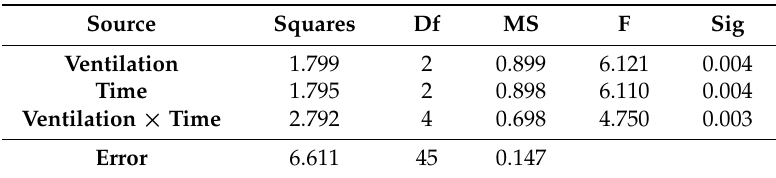
Table 4. Final analysis of variance (ANOVA) Table showing degrees of freedom (Df) mean square (MS), variance (F) and significance (Sig).